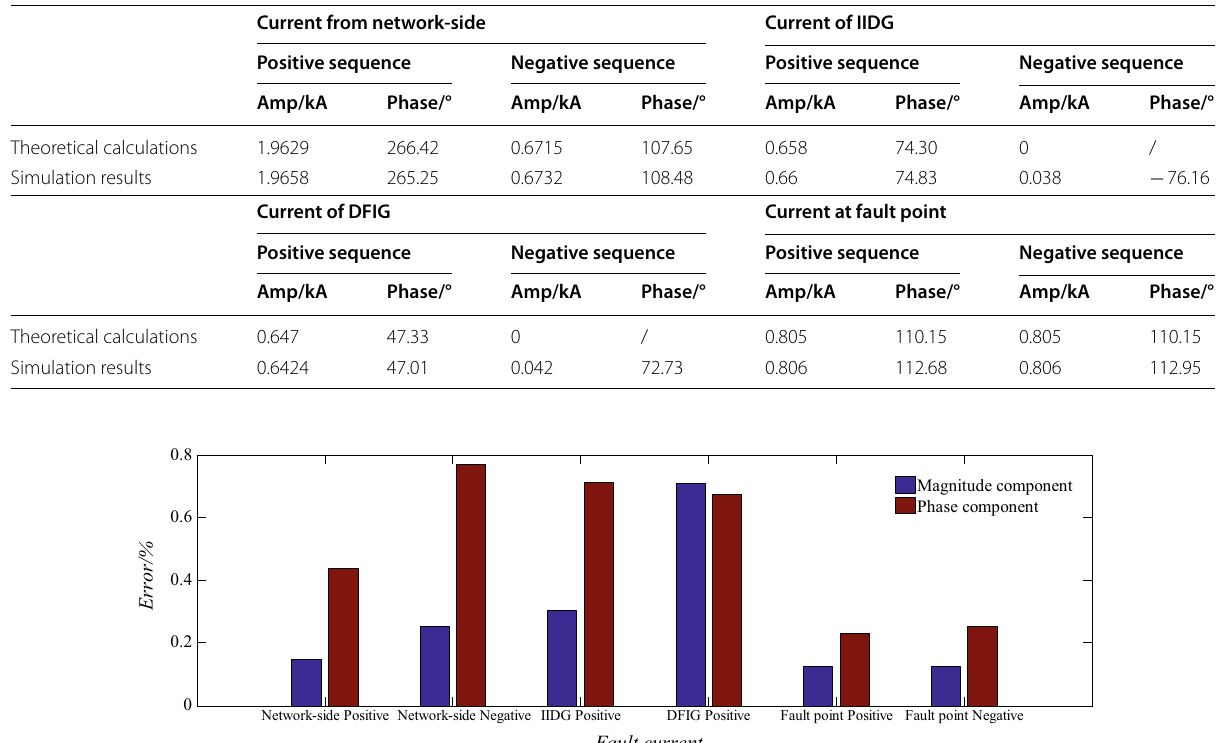
Table 5 Fault current calculations/simulations under a two‑phase fault at point f